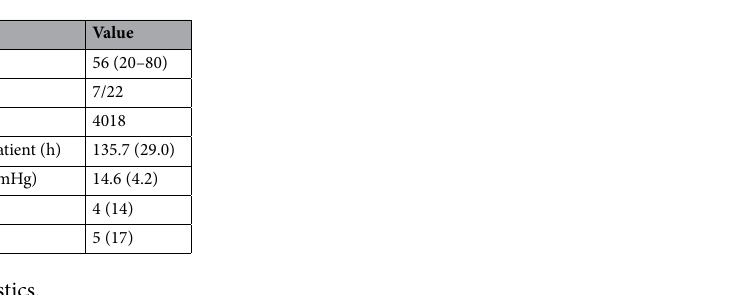
Table 1. Patient